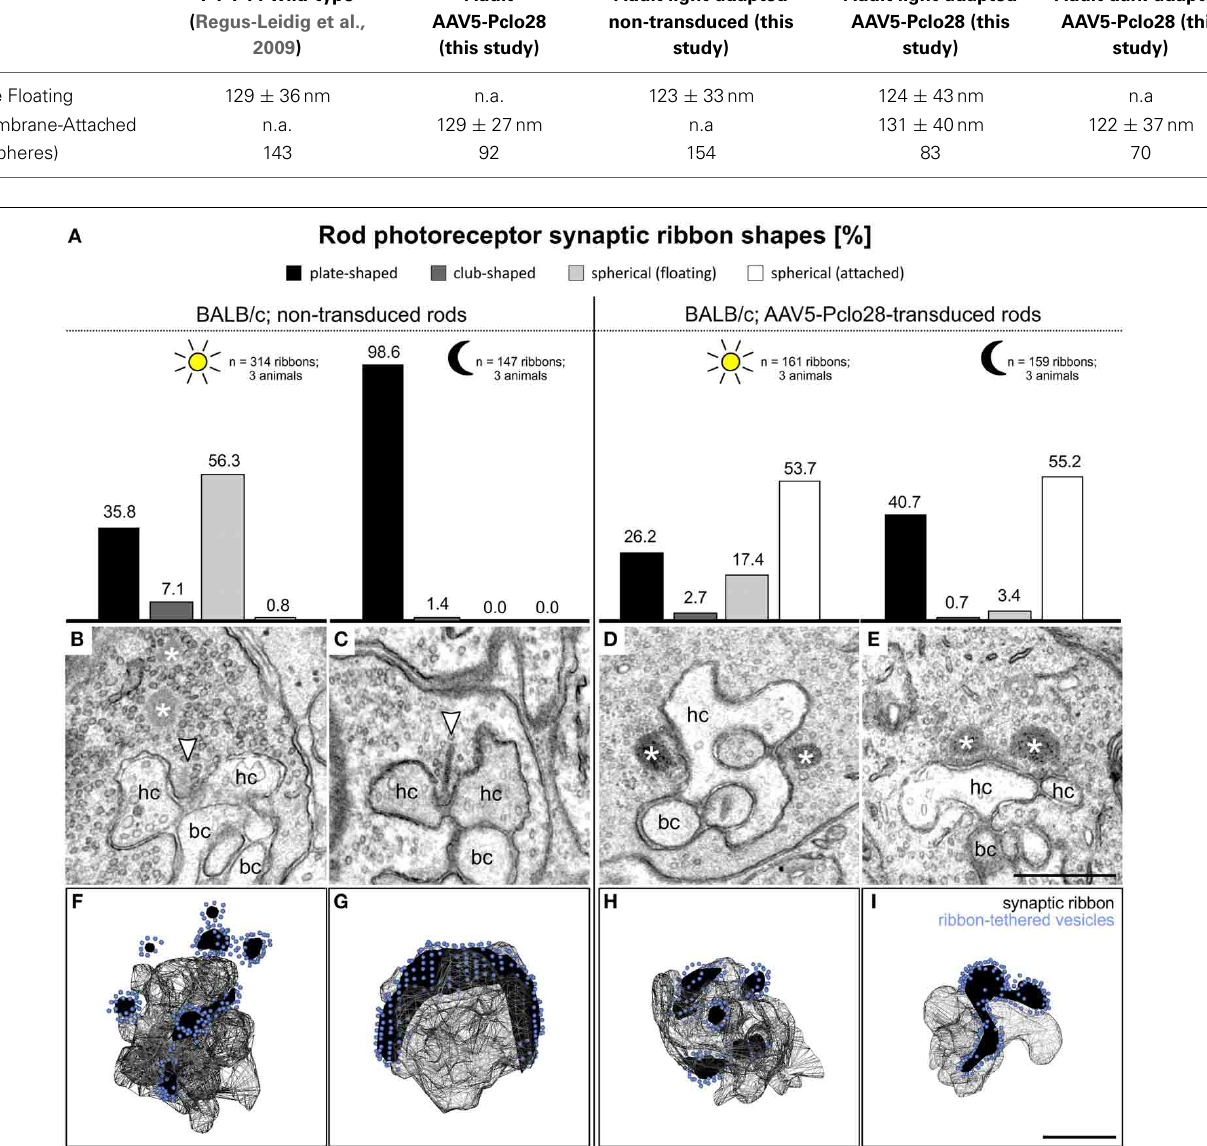
(E) BALB/c mouse retina. Arrowheads point to plate-shaped synaptic ribbons, asterisks demarcate free floating or membrane attached ribbon spheres. (F–I) 3D-reconstructions of representative rod photoreceptor ribbon synapses from non-transduced 3h light (F) and dark adapted (G) , and from AAV5-Pclo28-transduced 3h light (H) and dark adapted (I) BALB/c mouse retina. Synaptic ribbon material is shown in black, ribbon-tethered vesicles in blue. bc: bipolar cell; hc: horizontal cell. Scale bar in (E) for (B–E) and in (I) for (F–I) : 0.5 μ